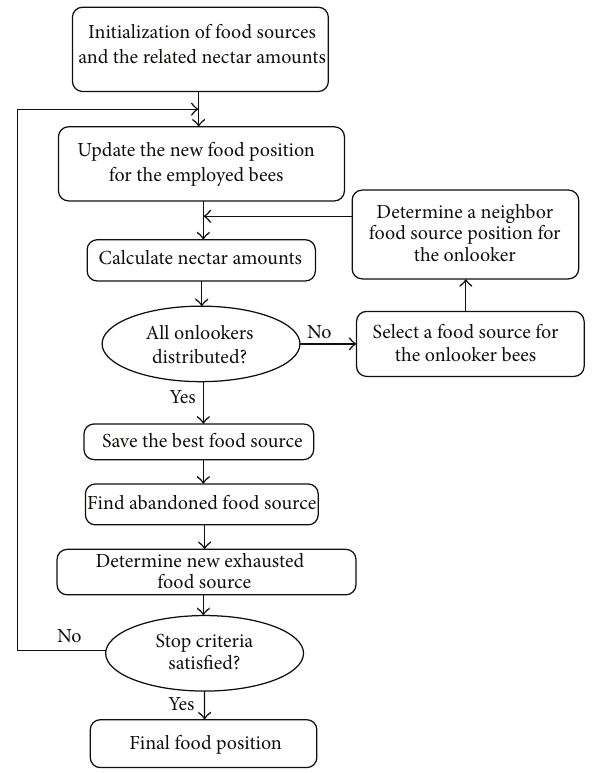
Figure 4: Flowchart of the parameter identification algorithm presented in